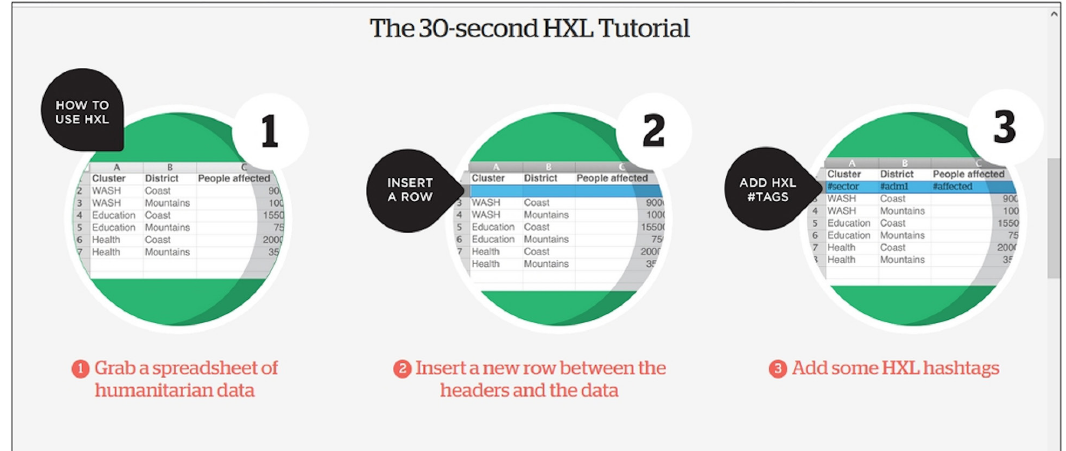
Fig. 1. Capture from https://hxlstandard.org United Nations’ HXL (screenshot). Source: Creative Commons Attribution